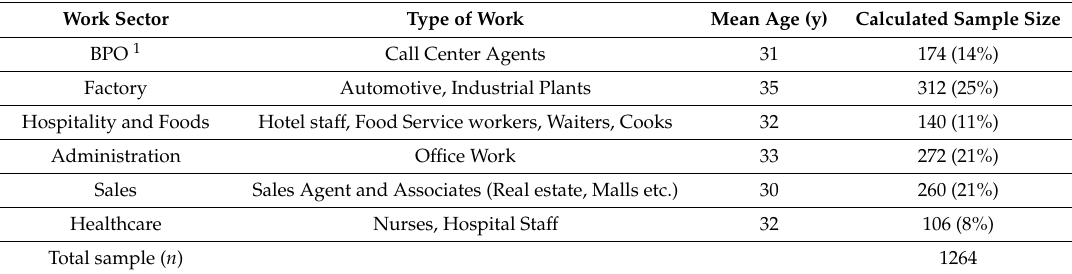
Table 1. Calculated sample size by job sector.